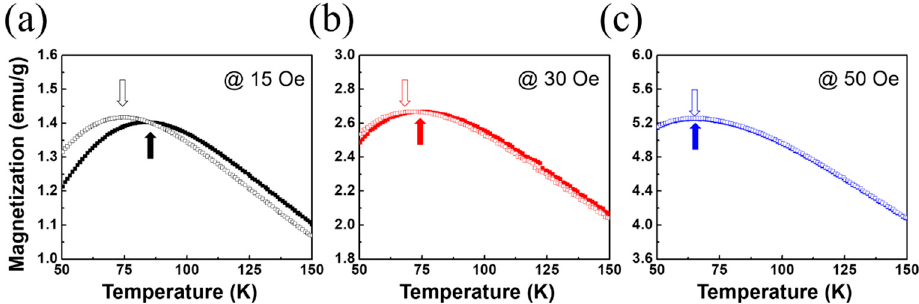
Figure 3. A blocking temperature shift effect depending on an external magnetic field under ZFC condition. The blocking temperature of two 15 nm magnetite nanoparticles synthesized with (open square) and without (solid square) alkaline metal complexes was compared with internal exchange coupling between core spins and disordered surface spins ( a ) under the external magnetic field of 15 Oe; ( b ) For an increase of the external magnetic field, exchange coupling leads to blocking temperature shifted to lower value; ( c ) all core spins were aligned to the magnetic field and the difference of exchange coupling effect was negligible under the magnetic field of 50 Oe.